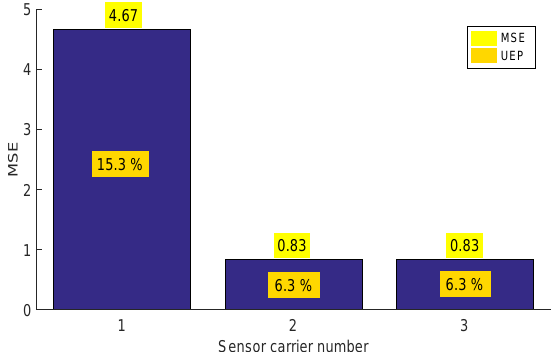
Figure 17. Mean squared error (MSE) and undetected echoes percentage (UEP) of the three sensor carriers for straight pipe